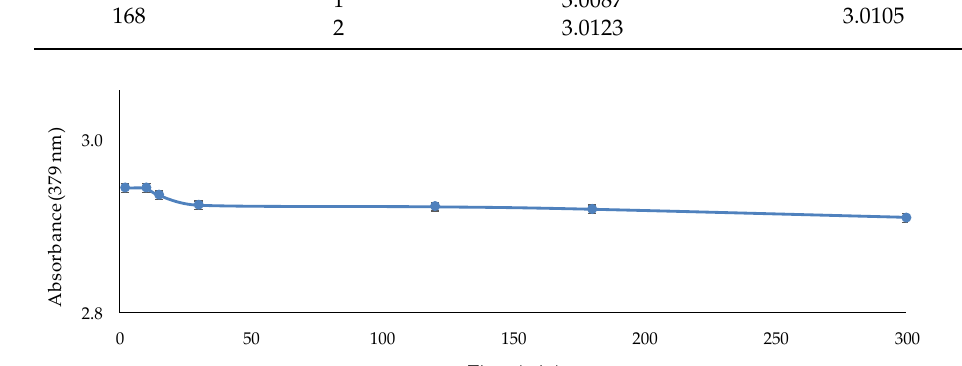
Figure A1. Study of the short-term stability of the optical sensor exposed to 1 mg L − 1 Cd(II).